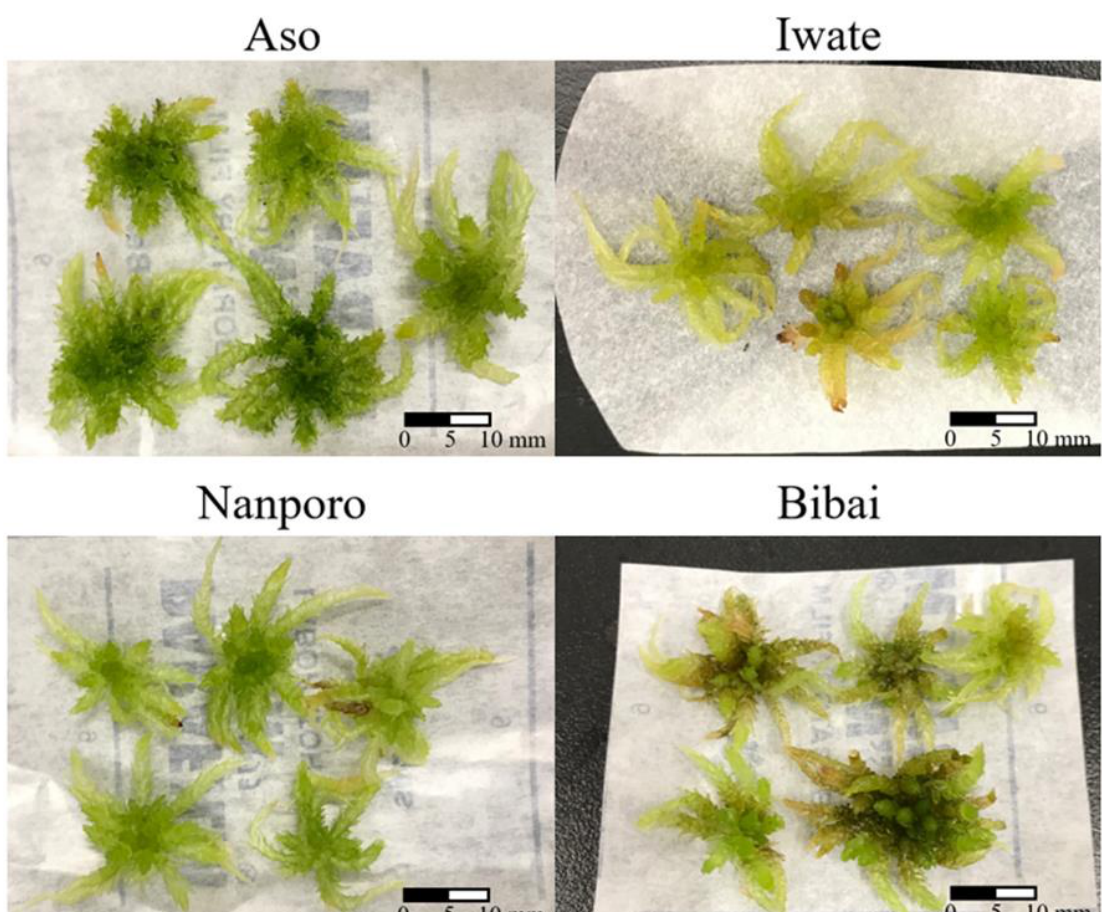
Figure 1. Typical-sized samples of Sphagnum palustre capitula from Aso, Iwate, Nanporo and